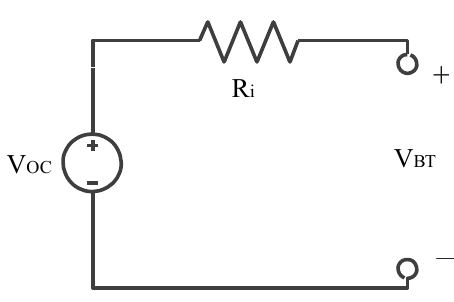
Figure 2. Model of the battery pack.